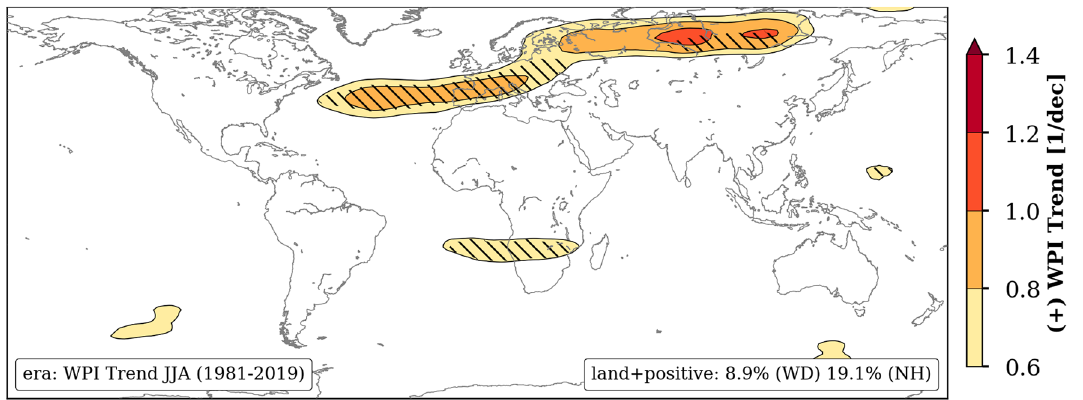
Figure 1. Observed trend pattern of WPI in Jun–Aug from 1981 to 2019 processed from ERA5 reanalysis data. Only positive and significant trends ( p -value < 0.05 using a two-sided t -test) are shown as contours and hatched, respectively. The values in the lower right box represent the percentage of grid cells over land showing positive ◦ − 1 trends larger than + 0.6dec , globally (WD) and north of 30 N (NH). The map was created by using python3- mpltoolkits.basemap (version 1.2.1, https:// matpl otlib. org/ basem